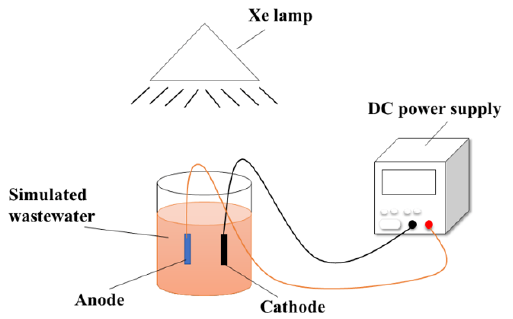
Figure 1. Schematic illustration of the simulated wastewater degradation.